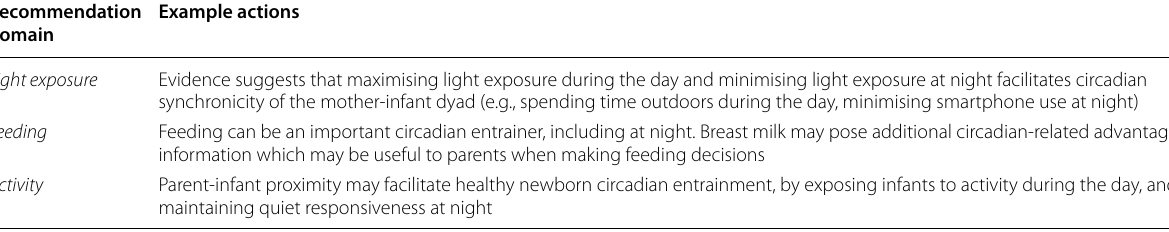
Table 1 Postnatal circadian rhythm-informed recommendations for practice Recommendation